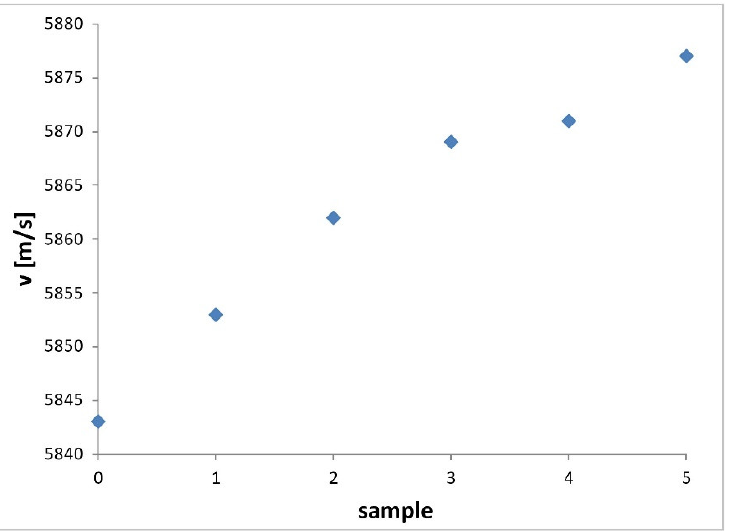
Figure 1. Values of ultrasonic velocity measured at frequency 12.2 MHz for forging samples with relative reduction 10% (1), 20% (2), 30% (3), 40% (4) and 50% (5), including non-forging sample (0).